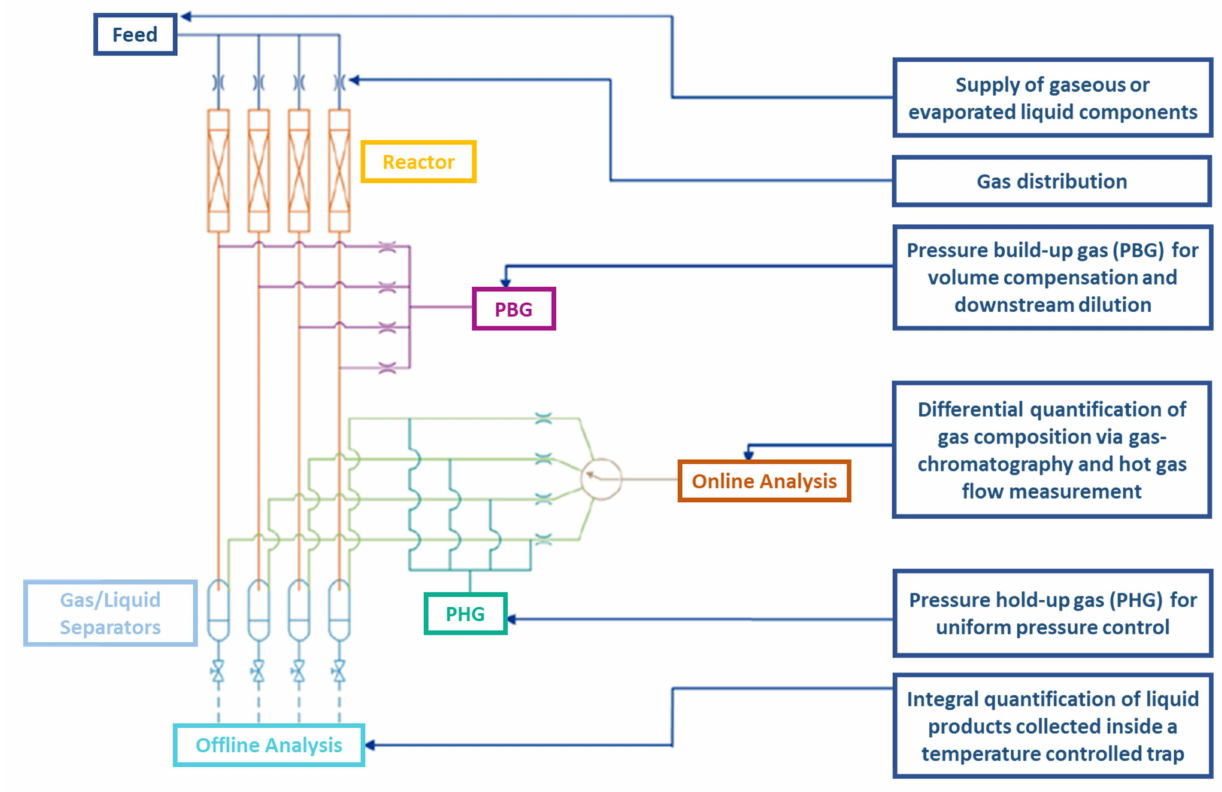
Figure 10. Simplified process scheme of a parallel test